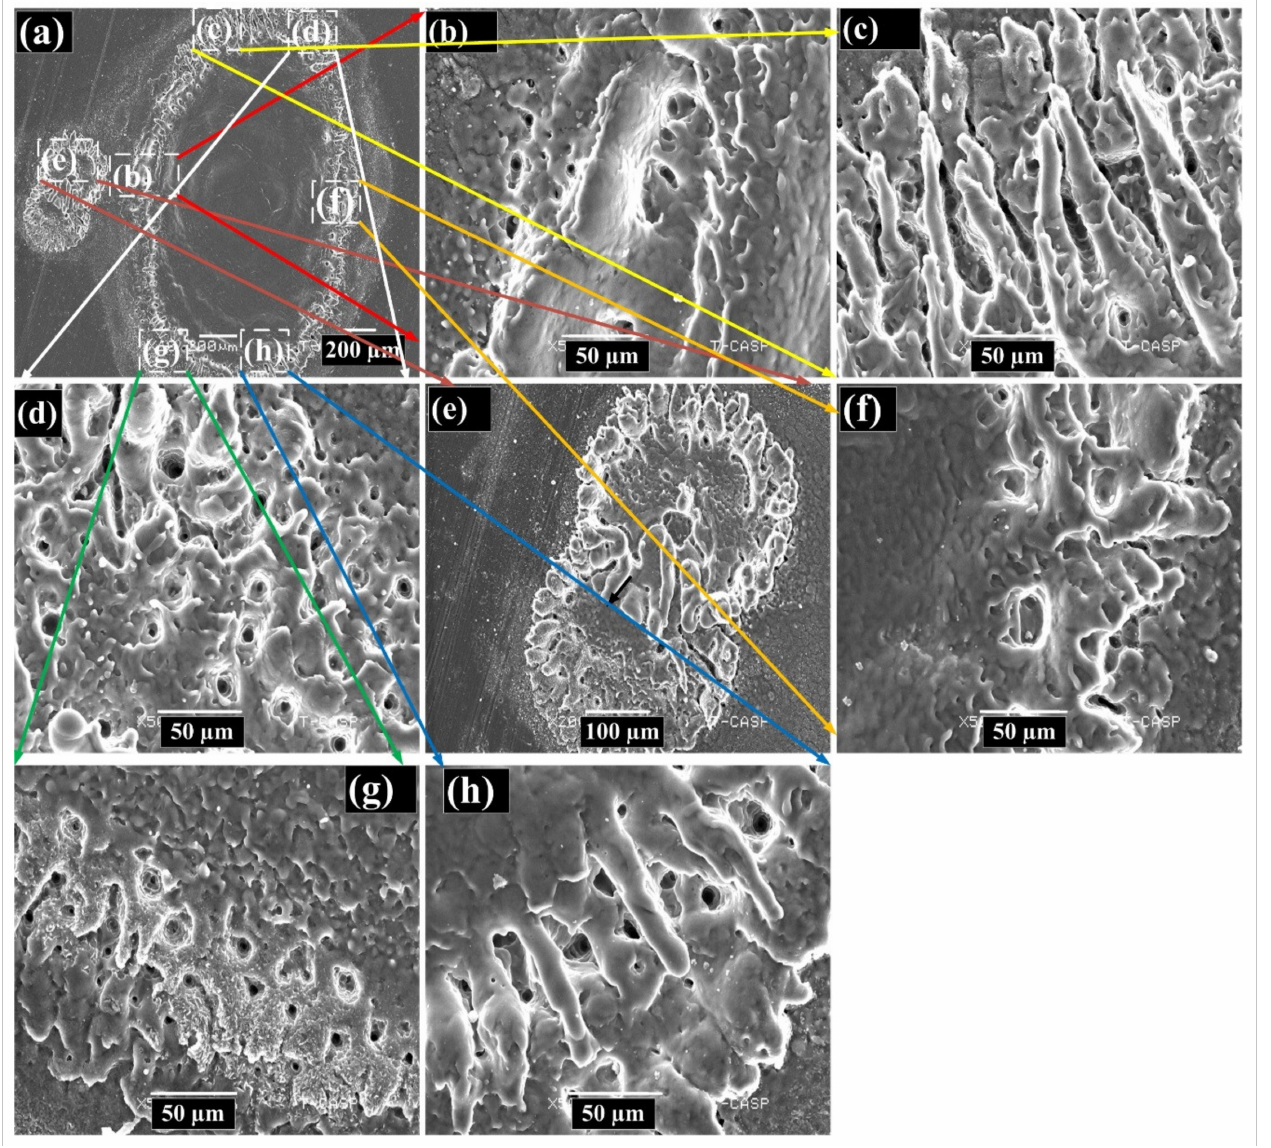
Figure 10. SEM micrographs exhibiting the variation in surface morphology under an ambient environment of Ar at a constant pressure of 5 Torr and a laser irradiance of 2.0 GW/cm 2 in the field-free case, where ( a ) laser-ablated crater on the Mg surface, ( b ) non-uniform melting of material and cavities at the boundary of the laser-ablated crater, ( c ) non-uniform micro-sized spikes and droplets at the laser-ablated crater, ( d – h ) various irregularly sized cones and